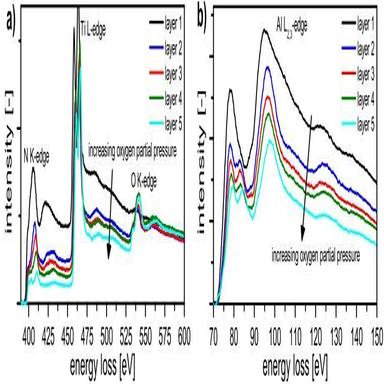
ELNES showing the shape of the a) N K-edge, Ti L-edge and O K-edge and b) the Al L2,3-edge of the five individual layers of the graded TiAl(O)N film.